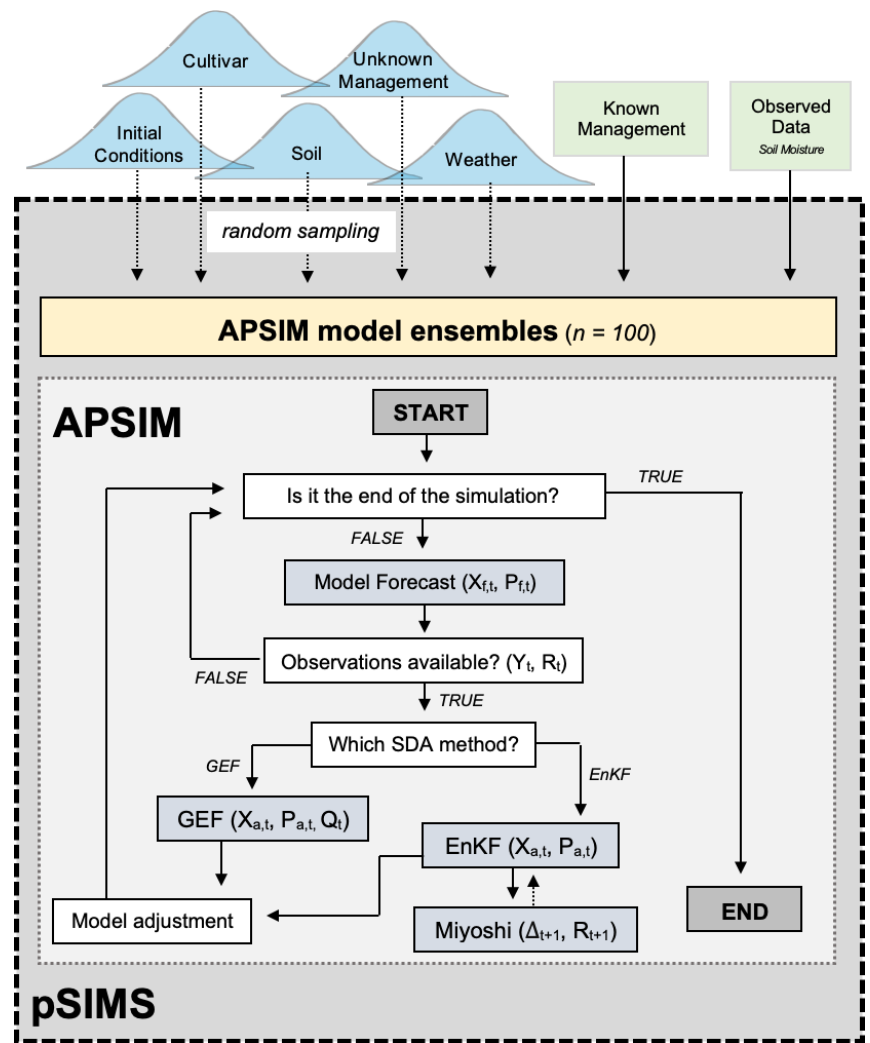
Figure 2. Schematic demonstrating the workflow of the data assimilation system. System inputs represented by blue normal distributions have incorporated uncertainty in this study, while green rectangles represent known values that were included as